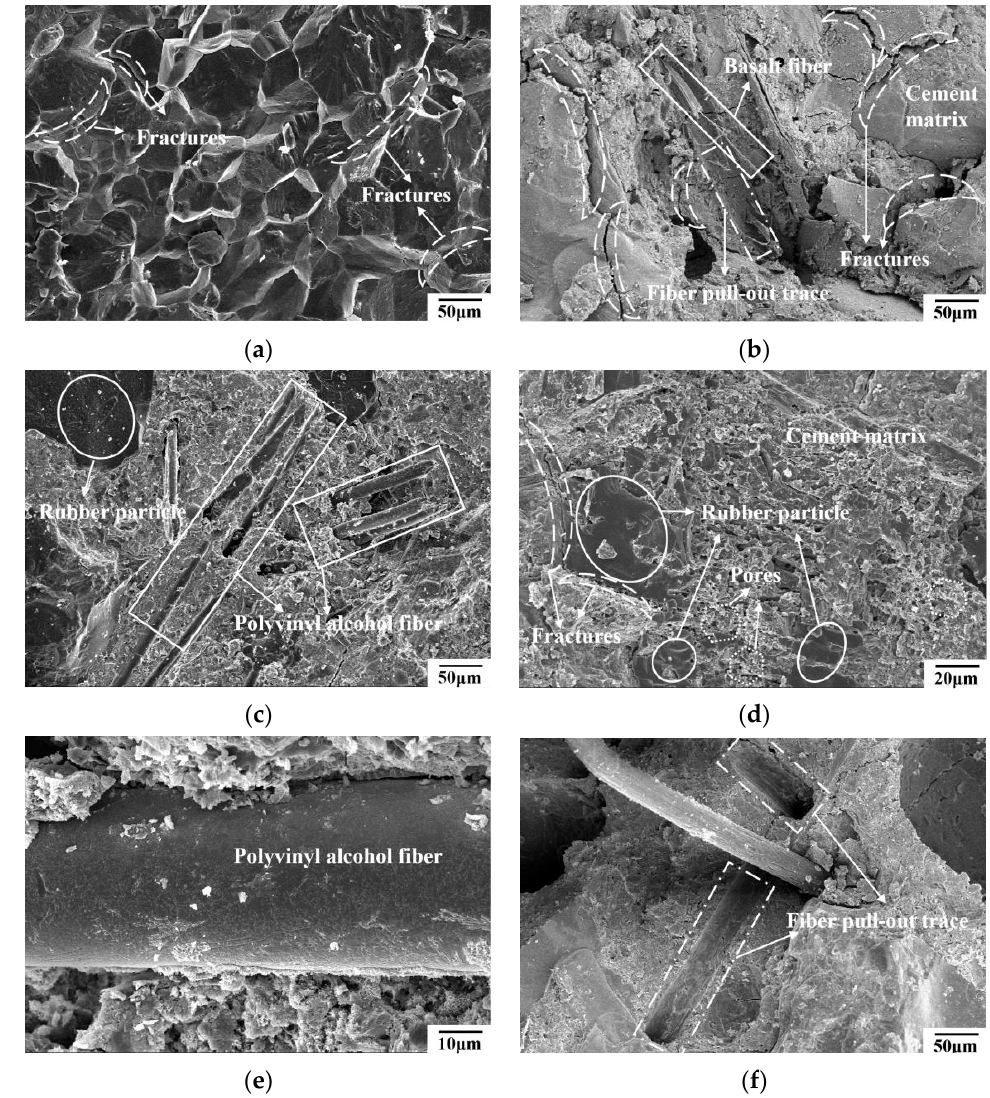
Figure 16. Micro-structures of the interfacial transition zone. ( a ) cement matrix; ( b ) basalt fiber/cement matrix; ( c ) polyvinyl alcohol fiber/cement matrix; ( d ) rubber particle/cement matrix; ( e ) polyvinyl alcohol fiber; ( f ) fiber pull-out trace.